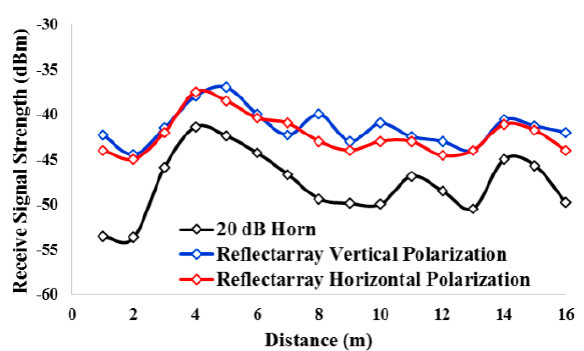
Figure 13. Comparison of measured RSS of asymmetric patch reflectarray antenna with standard horn antenna at a variable distance.